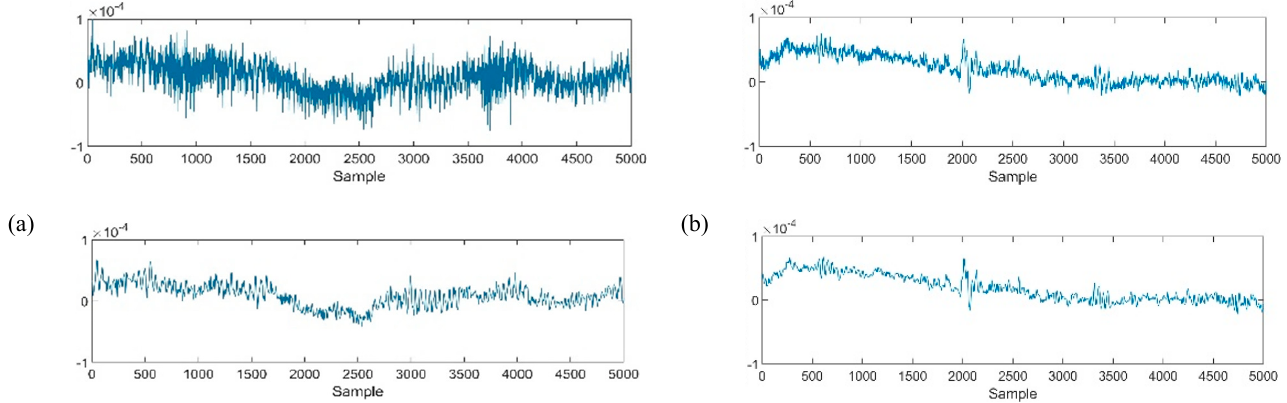
Figure 3. Samples of raw signals (top) and de-noised signals (down) of normal ( a ) and epileptic ( b ) signals recorded from T4 − T6. The X-axis shows the potential difference (µv).